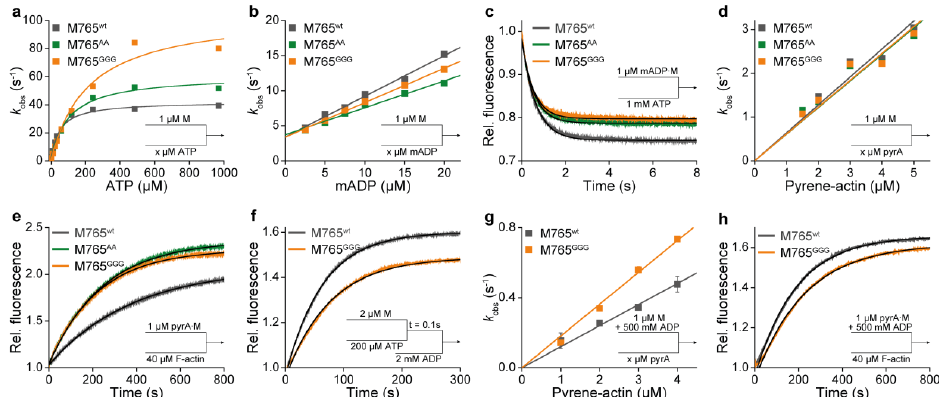
Figure 4. Interactions of myosin with nucleotides or actin. ( a ) Apparent second order rate constants of ATP binding to myosin ( K 1 k +2 ) and ATP hydrolysis rate ( k +3 + k -3 ) were obtained from the hyperbolic dependence of k obs on ATP. ( b ) Appar- ent second order rate constant of mADP binding to myosin ( k -5 K 6 ) was obtained from the slope of the linear dependence of k obs . ( c ) Rate of ADP release ( k +5 ) upon mixing 1 µM M∙mADP complex with excess ATP and fitting the transient to single exponential function. ( d ) Apparent second order rate constant of actin binding to myosin ( k’ +A ) was obtained from linear fits to the k obs data. ( e ) Actin dissociation kinetics. An amount of 1 µM pyrene–actomyosin complex was mixed with excess unlabeled F-actin and the rate of actin dissociation ( k’ -A ) was obtained from exponential fits to the transients. ( f ) Rate of P i release ( k +4 ). An amount of 2 µM myosin was mixed with 200 µM ATP, aged for 0.1 s, and subsequently mixed with 2 mM ADP. All solutions contained 5 µM MDCC-PBP. ( k +4 ) was obtained from exponential fits to the transients. ( g ) Apparent second order constant of actin binding to ADP–myosin ( k’ +DA ) was obtained from the linear dependencies of k obs on pyrene-actin concentration. ( h ) Actin dissociation from the A∙M∙D complex. An amount of 1 µM pyrA∙M pre-incubated with excess ADP was mixed with excess unlabeled F-actin and the rate of actin dissociation ( k -DA ) was obtained from single exponentials fits.